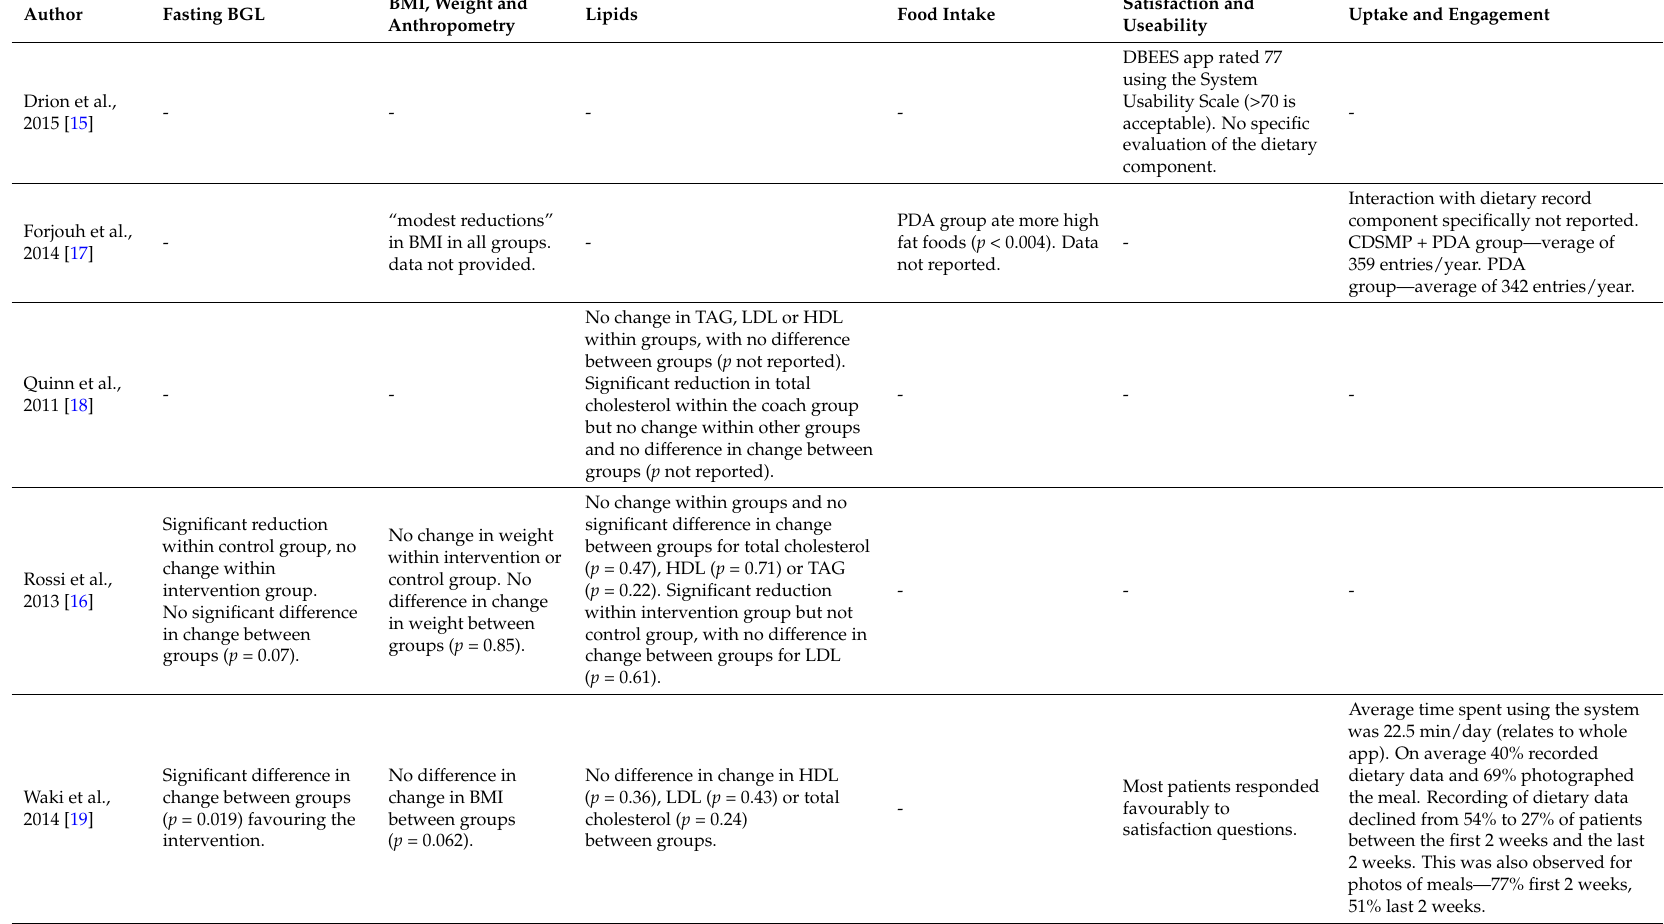
Table A1. Secondary outcomes of studies exploring the effect of using mobile devices to record food or nutrition intake on diabetes control and nutrition